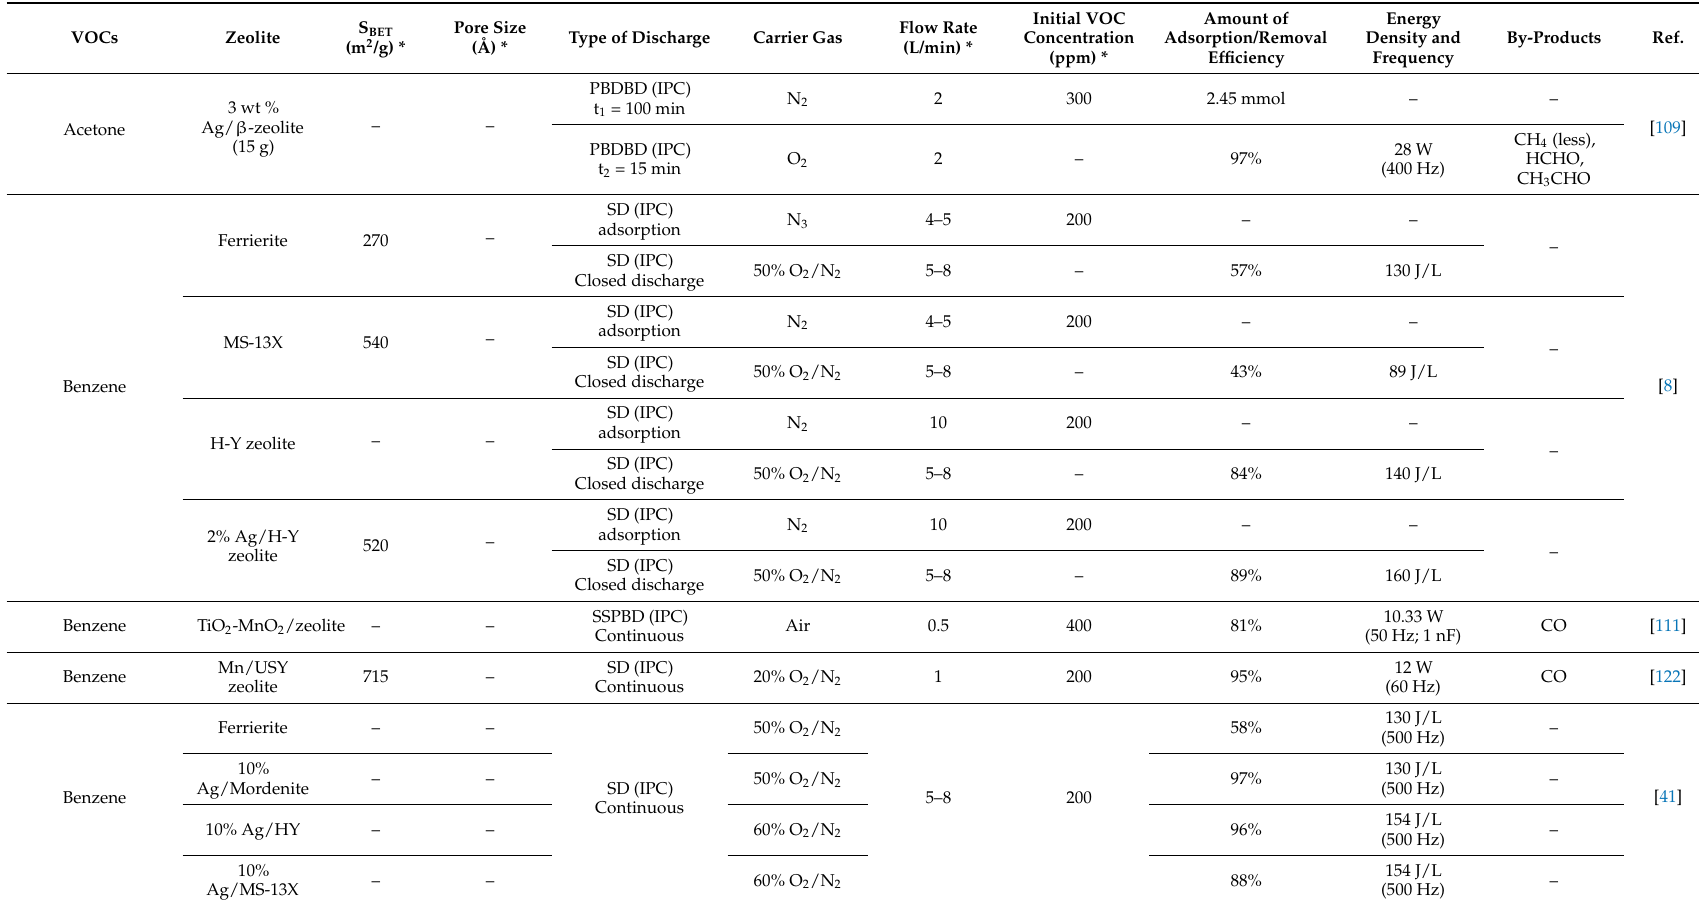
Table 4. Overview of published papers on abatement of VOCs using zeolites in combination with non-thermal plasma